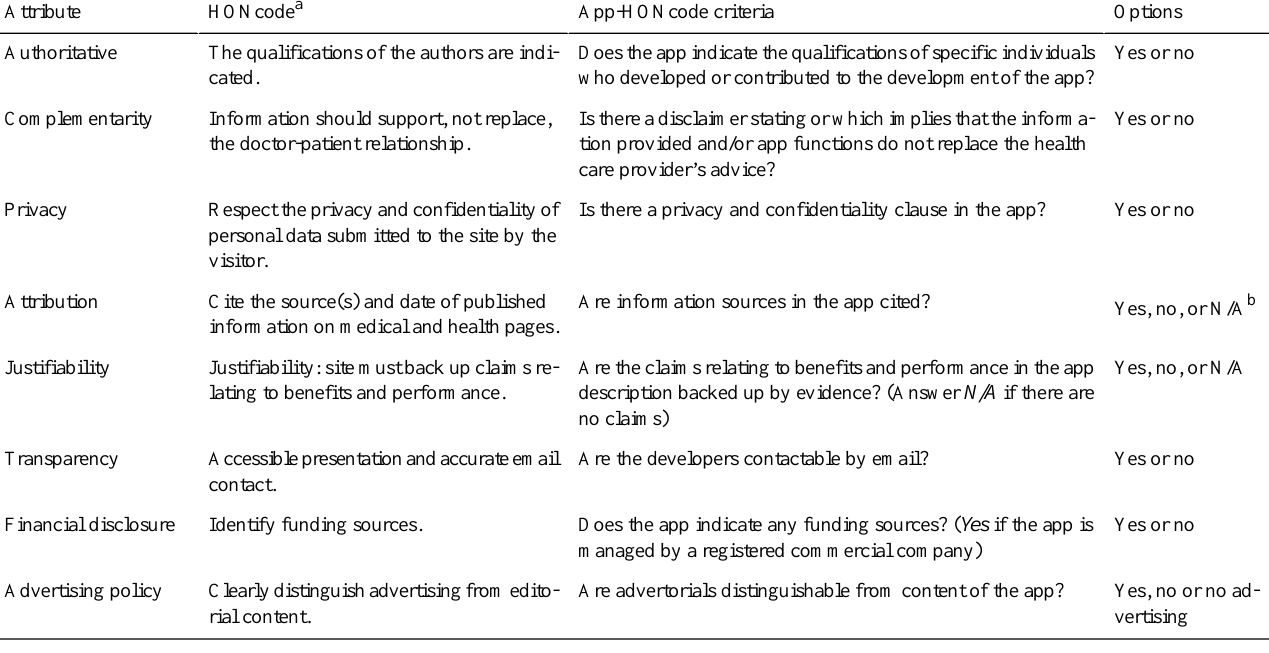
OptionsApp-HONcode criteriaHONcode a Attribute